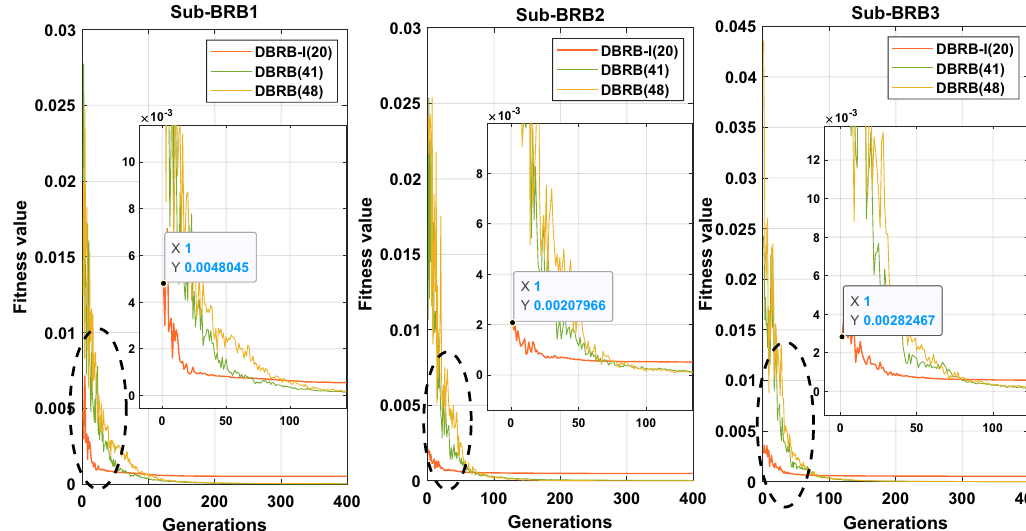
Figure 24. The fitness value of the DBRB model over 400 generations.